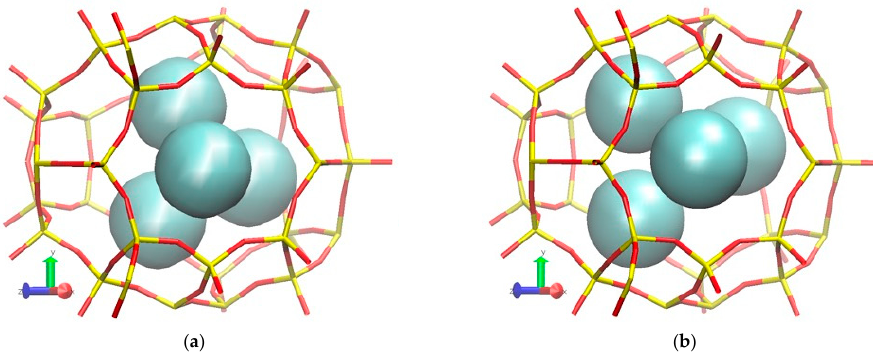
Figure 5. Molecular visualization of Kr atoms filling up inner cages of DD3R membrane using molecular trajectories from simulations ( a ) at 300 K and 150 atm and ( b ) at 300 K and 75 atm.